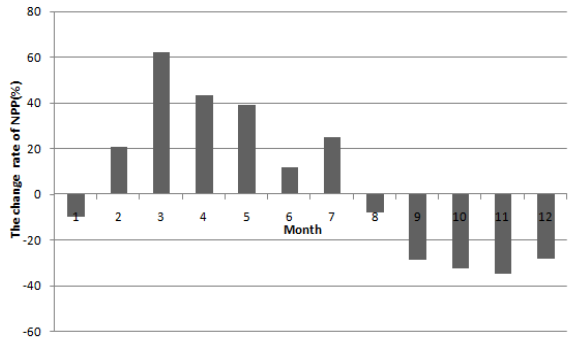
Figure 6. The change rate of monthly NPP from the year 2001 to 2011.